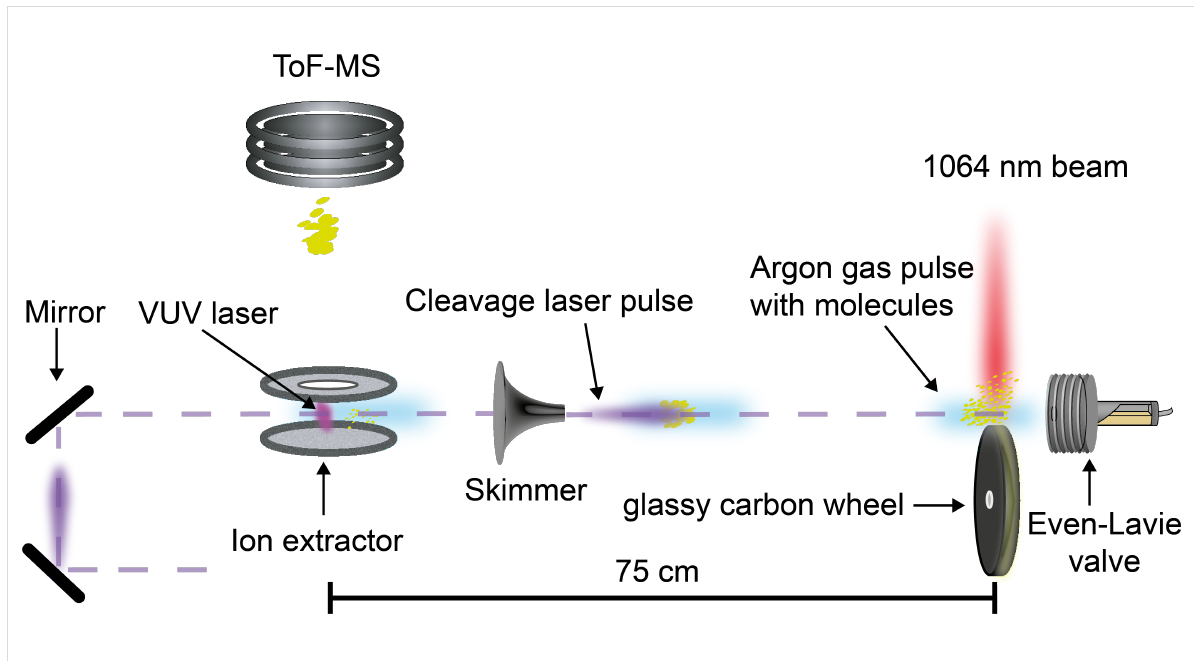
Figure 4: Molecular beam machine to study the photodepletion of the photoactive monomer in high vacuum. The pulsed infrared laser beam desorbs the molecules which are entrained by the adiabatically expanding neon gas jet. The neutral beam propagates for 75 cm in high vacuum before it is ionized by the pulsed radiation of a 157.6 nm F 2 laser and analysed in a time-of-flight mass spectrometer. On the way to the detector the molecular beam is exposed to a collinear UV laser beam at 266